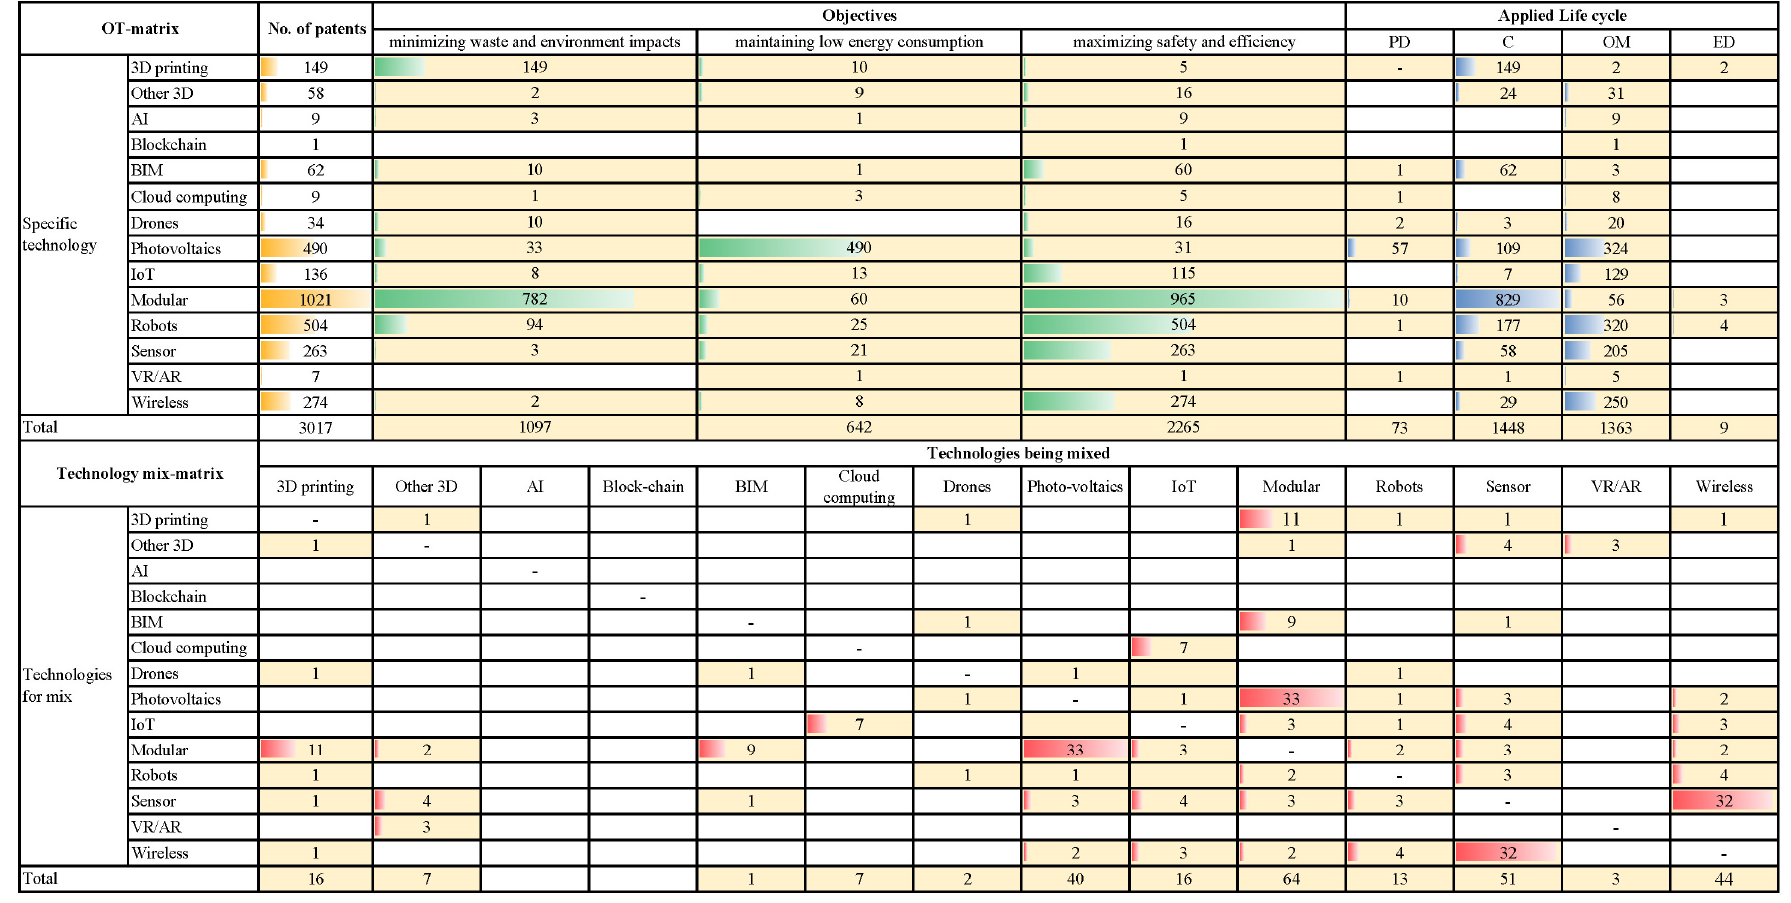
Figure 5. Objective-technology and technology-mix matrix.